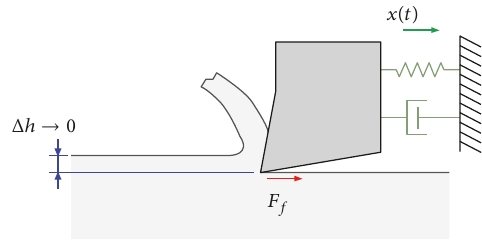
Figure 1: Dynamic friction forces under minimum depth of